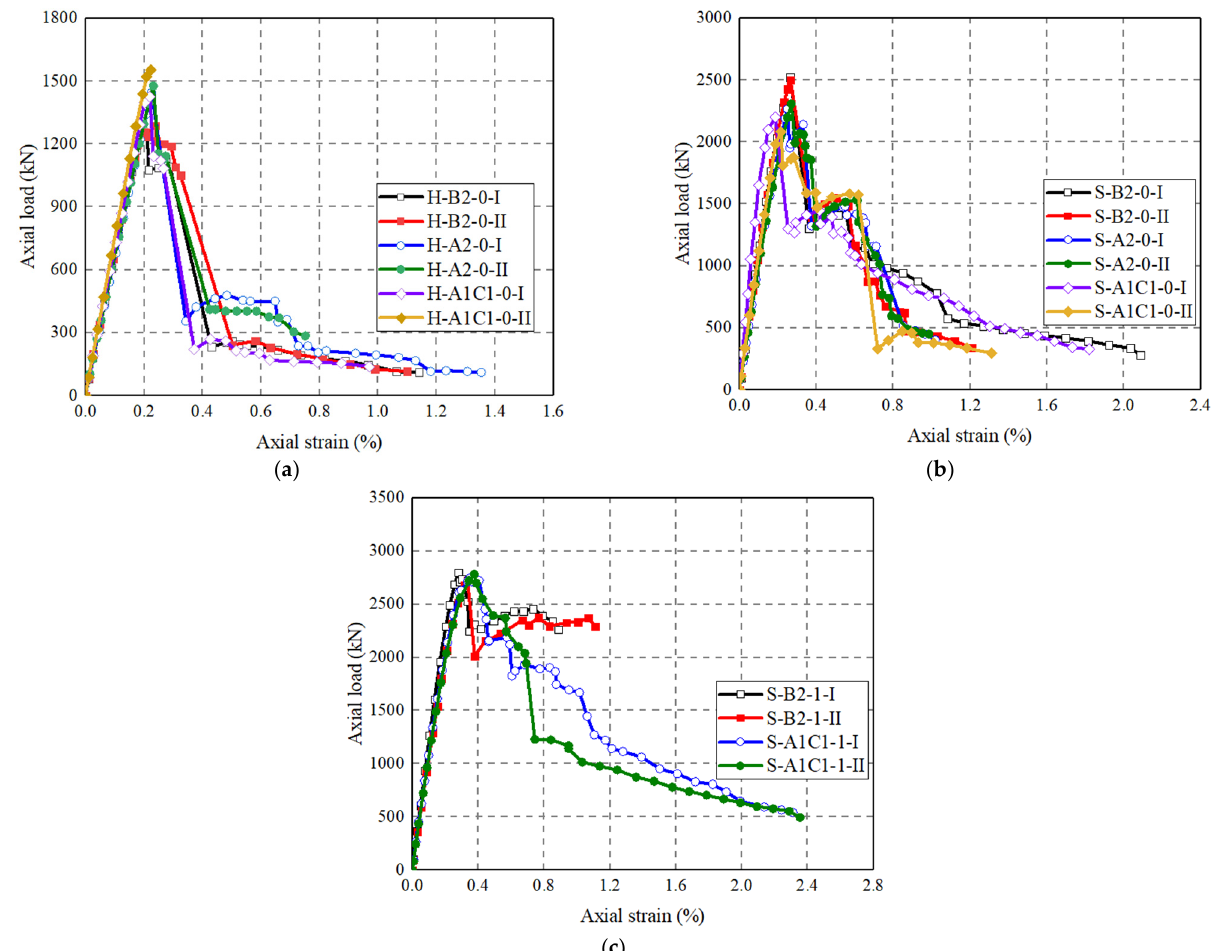
Figure 11. Effect of CFRP grid positioning on axial load–strain curves. ( a ) FRP grid-UHPC tubular columns; ( b ) Concrete-filled FRP-grid UHPC tube columns; ( c ) CFRP-confined concrete-filled FRP- grid UHPC tube columns.